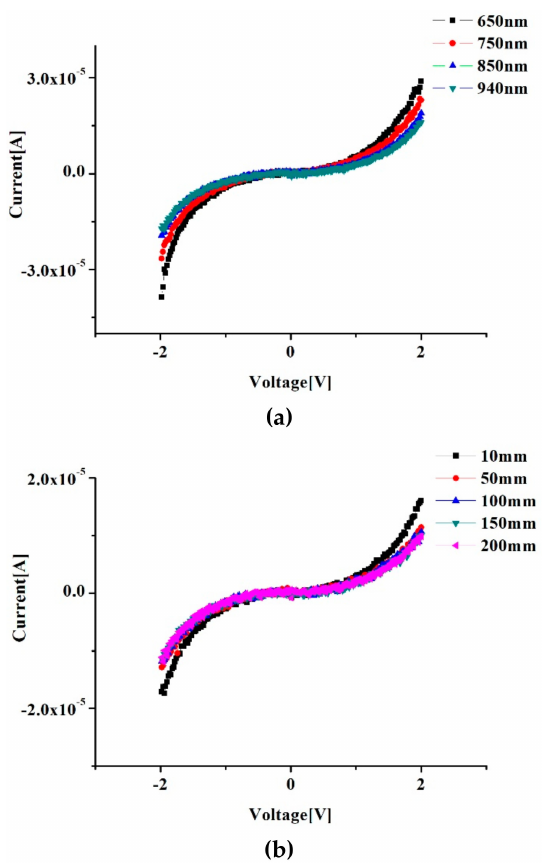
Figure 3. Relationship between voltage and current when graphene is irradiated by light sources with di ff erent wavelengths ( a ) and irradiated at di ff erent distances ( b